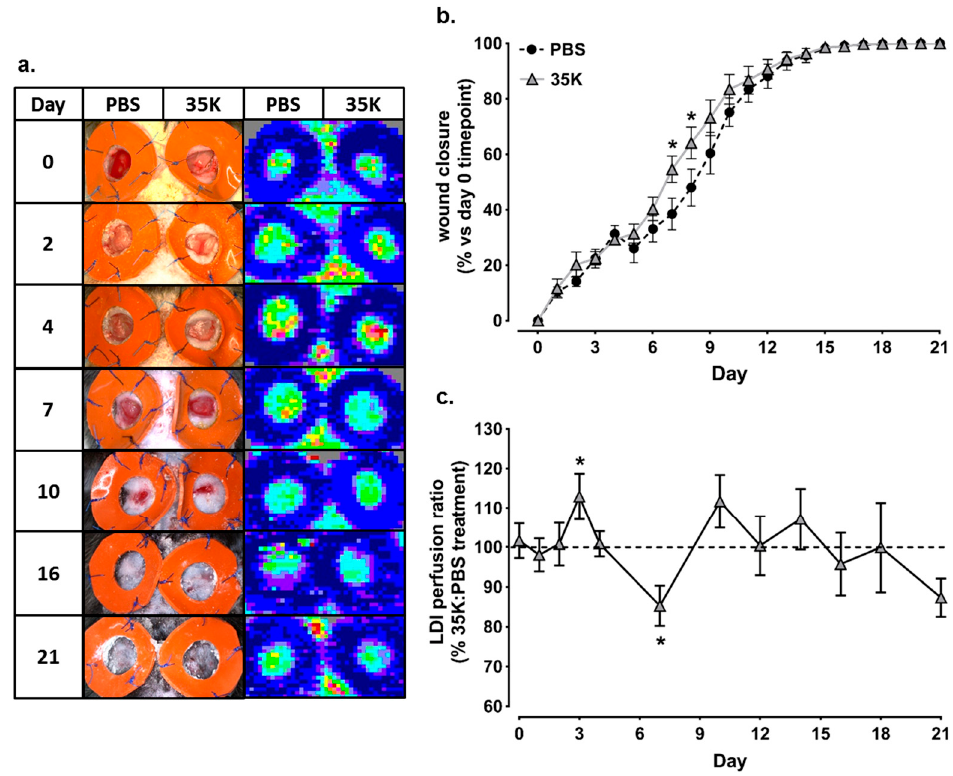
Figure 1. Topical 35K increases the rate of wound closure and wound blood perfusion in early-mid stage wound repair. Two full thickness wounds were created on C57Bl/6J mice ( n = 7–12). Mice received daily topical application of 35K protein (200 nM) or PBS (vehicle). ( a ) representative images of the wounds and wound blood perfusion using Laser Doppler imaging (high (red) to low (blue) blood flow); ( b ) wound area was calculated from the average of three daily diameter measurements along the x -, y - and z -axes. Wound closure is expressed as a percentage of initial wound area at Day 0. Black circles are PBS treated wounds; grey triangles are 35K treated wounds; and ( c ) the 35K:PBS wound blood flow perfusion ratio was determined using Laser Doppler imaging (LDI). Data is represented as mean ± SEM. Points above the dotted line represent an improvement with 35K treatment. Statistical analysis was performed by an unpaired two-tailed t -test. * p < 0.05 compared to PBS treated wounds.